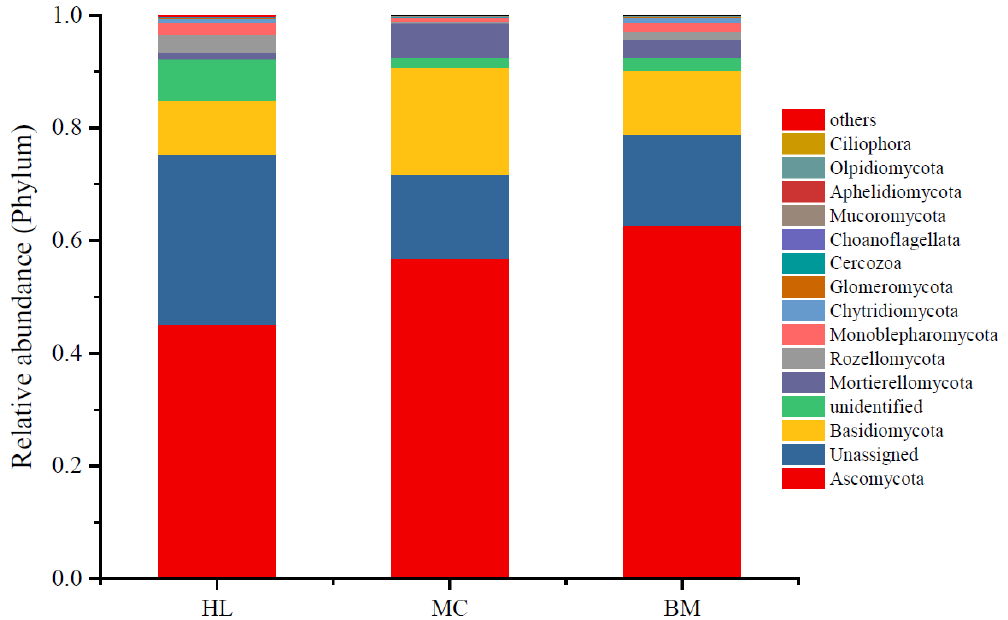
Figure 1. Fungal community variation in the three wetlands. The mean relative abundance of fungi from eight samples taken from each wetland. Each bar height represents the relative abundance, and color represents a particular fungal phylum. HL, MC and BM represent the Huahu Lake wetland, Mangcuo Lake wetland and Baima Snow Mountain wetland, respectively.